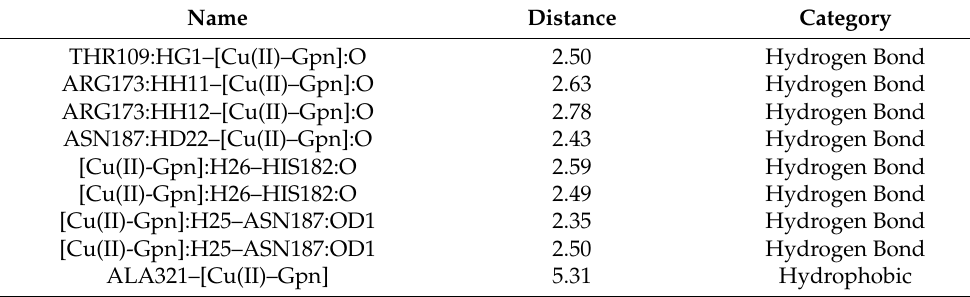
Table 5. The Gpn–serotonin interaction results by Discovery Studio. Name